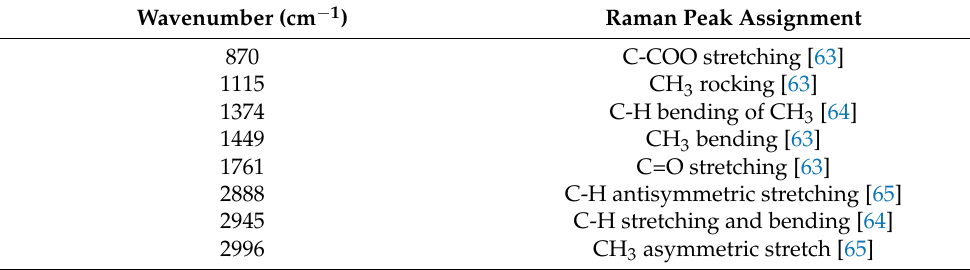
Table 1. Major identified Raman peaks and their related